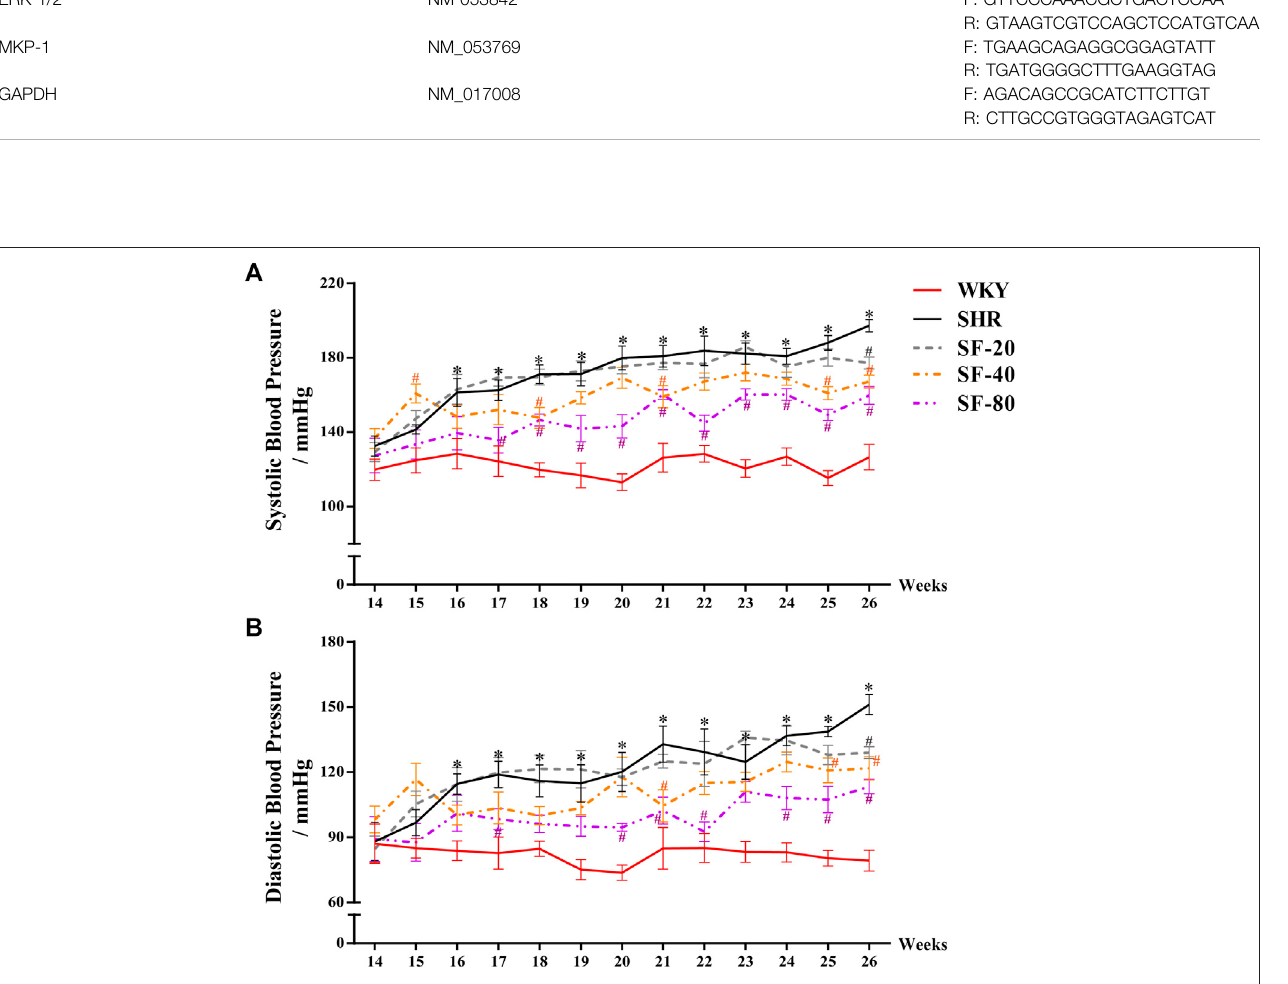
Frontiers in Pharmacology |